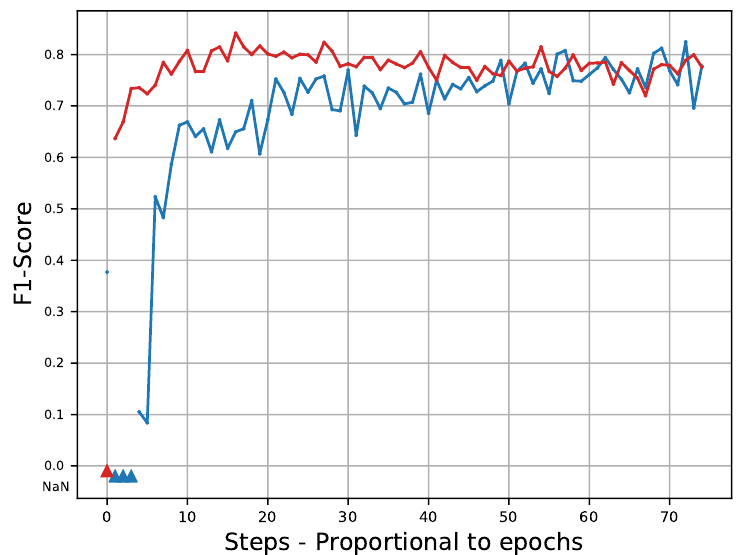
Figure 10. Evolution of F1 -Score during training for Class 1 calculated on validation set. Blue curve corresponds to a training set with no oversampling ( η ≈ 0.3) and red curve correspond to a training oversampled with η = 0.9. Triangles stand for undefined F1 -score.